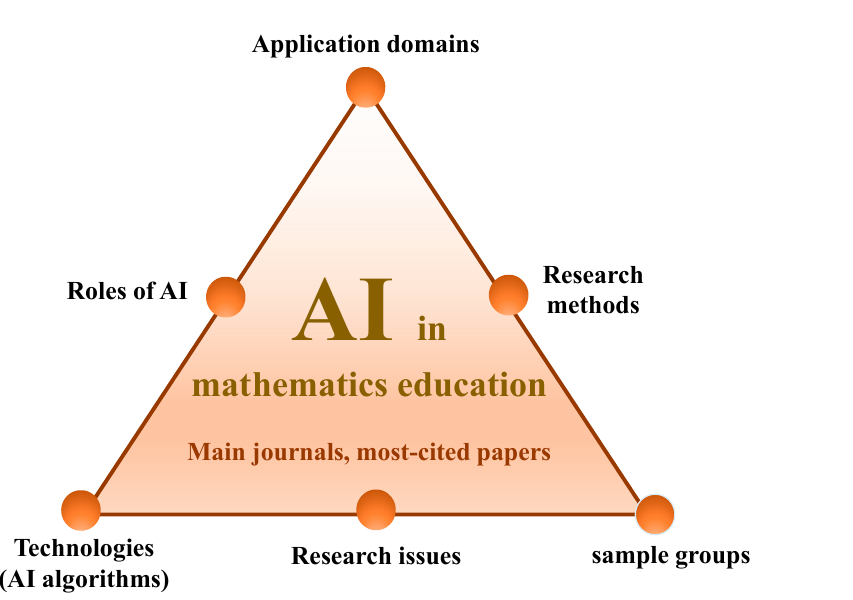
Figure 2. Model for reviewing artificial intelligence (AI) in mathematics education (AIME) research.